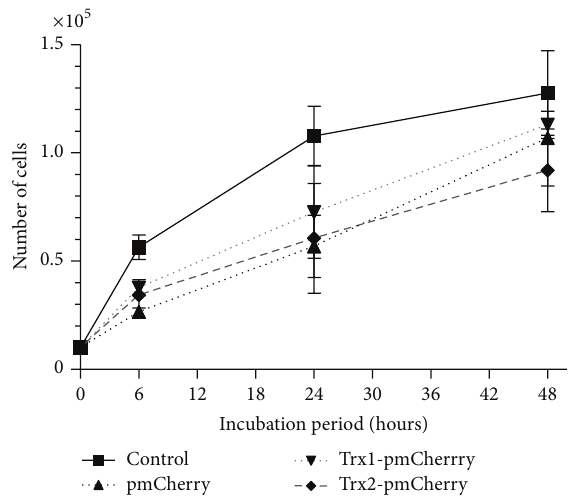
Figure 3: Proliferation analysis. Uninfected ARPE cells and cells infected with AAV-Trx1 or AAV-Trx2 were plated on a 24-well cultureplateat1 × 10 4 cells/well.Thenumberofthecellswascounted at 6, 24, and 48 hours after seeding using a TC20 Cell